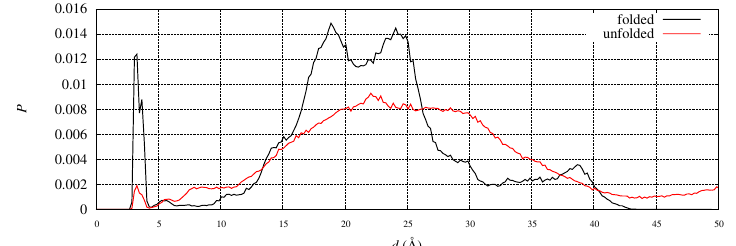
Figure 11. Distribution of the distance between N in the first residue (N(Leu 90)) and C in the last residue (C(Ala 210)) in folded (CV = 14, black curve) and unfolded (CV = 4, red curve) states of the wild-type (WT)